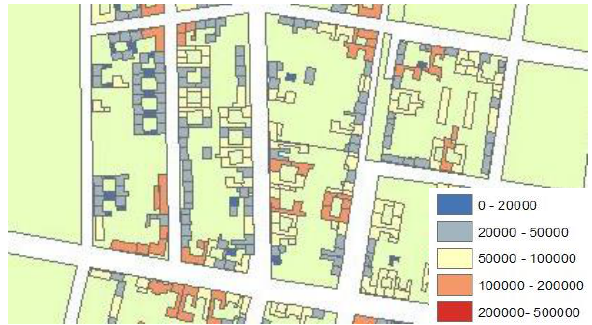
Figure 7. Map representation of coloured buildings regarding